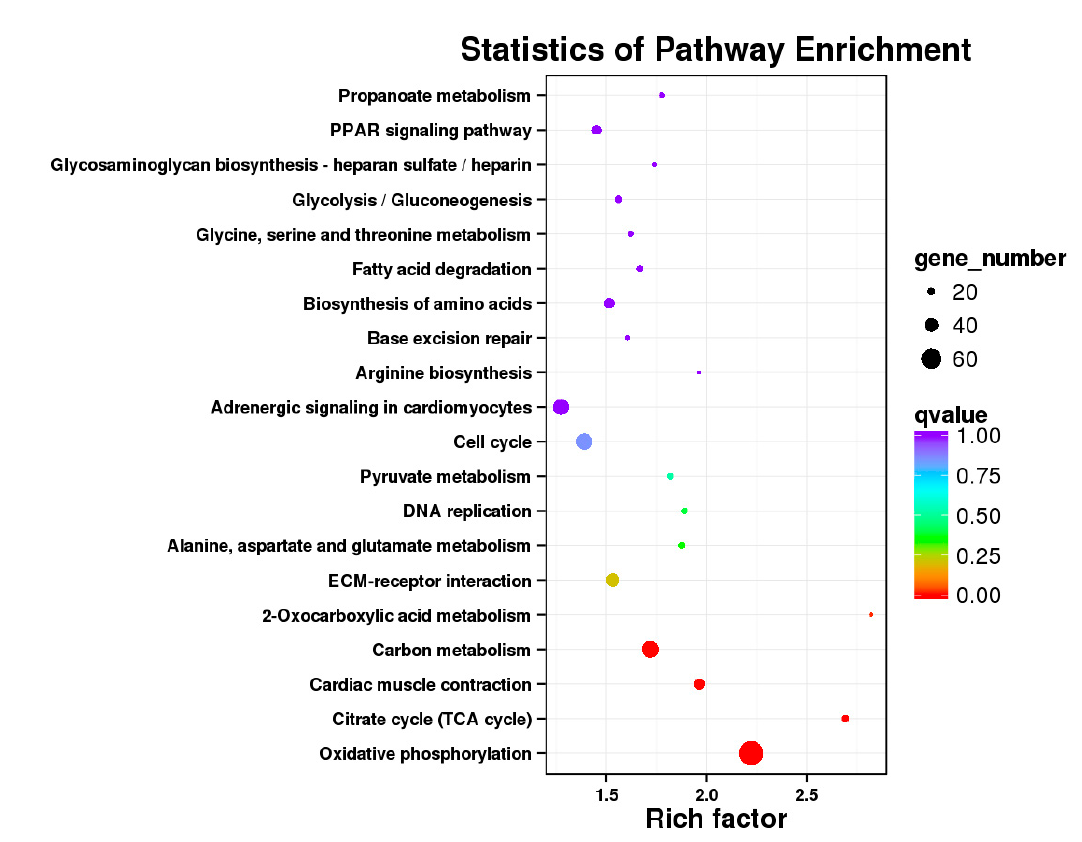
Figure 17. KEGG annotation of DEGs in leg muscle of BE17L_vs_BM6L.